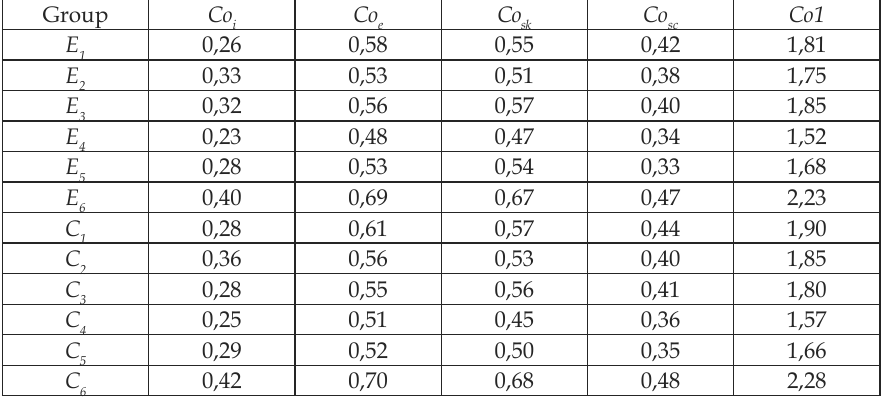
Table 2. 1 Results of pre-experimental testing (reading and comprehension skills